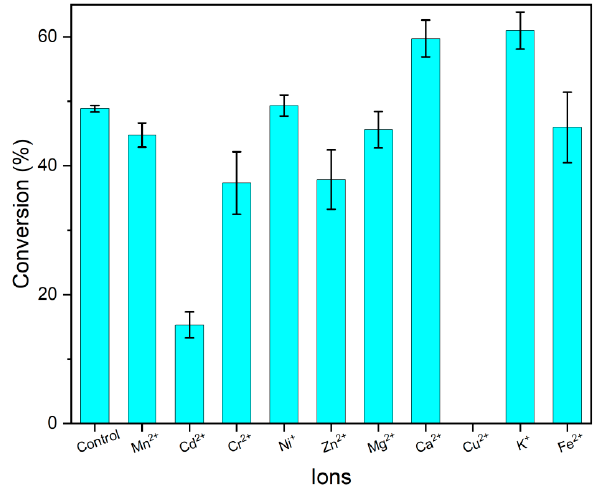
Figure 7. The effect of metal ions on the reduction of acetophenone using catalyzed by B. cereus TQ-2 whole cells. The general reaction conditions used otherwise stated: 2 mM of substrate, 0.1 g/mL of microbial cells, 1.0 mM of K + , 15% ( v/v ) of glycerol, 5 mL of Tris-HCl buffer (100 mM, pH 8.0), and 600 rpm for 48 h; 1.0 mM of various ions was added. Error bars indicate standard deviation.